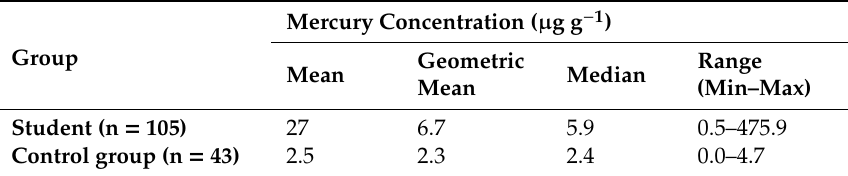
Table 2. Mercury concentration in the scalp hair.